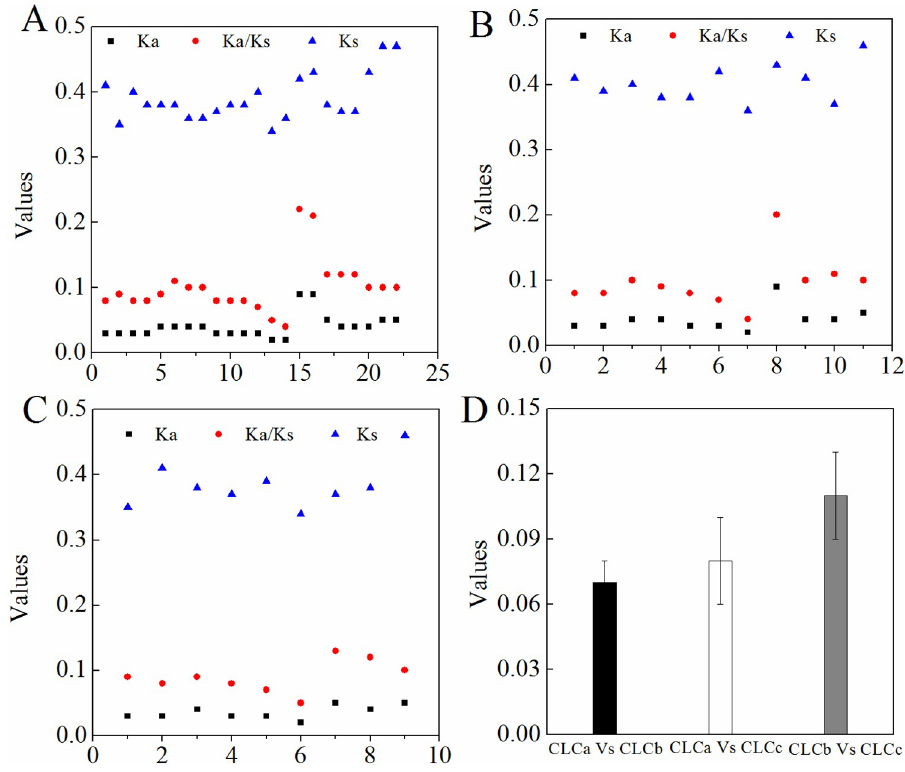
Fig 5. The synonymous substitution rates (Ks) and non-synonymous substitution rates (Ka) of the CLC family proteins in Brassica crops. The values of Ks, Ka and Ka/Ks in B . rapa (A), B . oleracea (B) and B . napus (C). The DIVERGE v. 3.0 program was used to detect the type-II functional divergence of the homologs located in the tonoplast in B . napus (D).